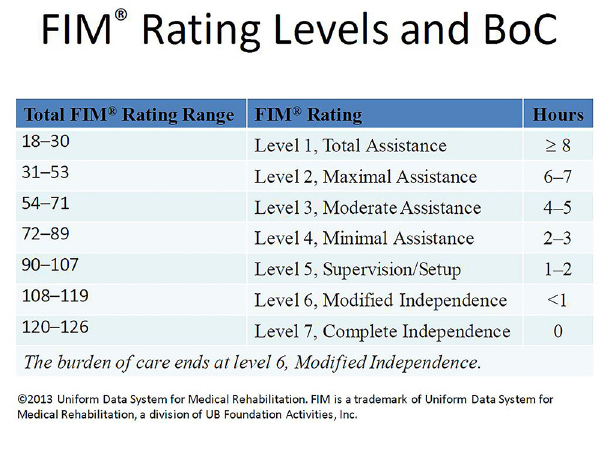
FIGURE 2 | FIM rating levels and burden of care (BoC). This figure is a slide presented by Paulette Niewczyk, MPH, PhD, Director of Research, at UDSMR’s 2013 Annual Conference in Orlando, Florida (Permission to reuse this slide was obtained from UDSMR in 2018).